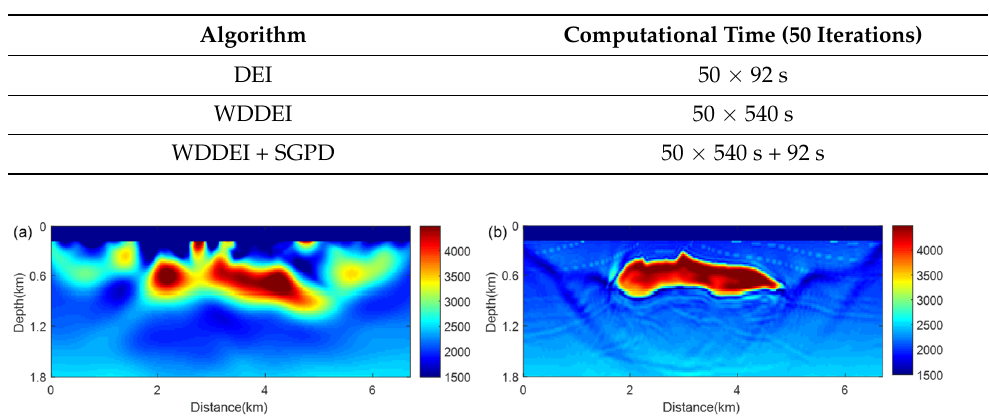
Table 1. Computational costs comparison between DEI, WDDEI and WDDEI + SGPD.